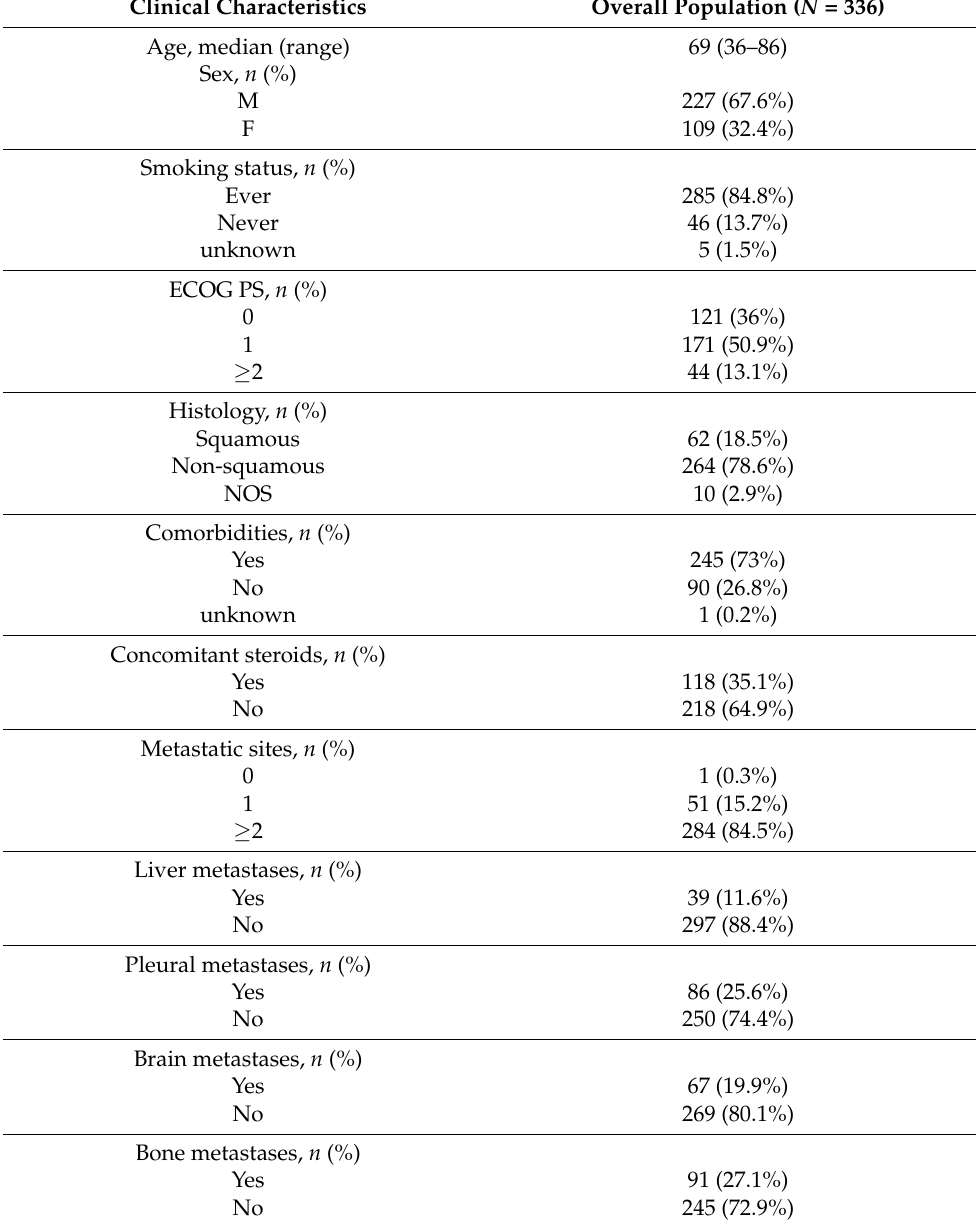
Table 1. Clinical characteristics of the study